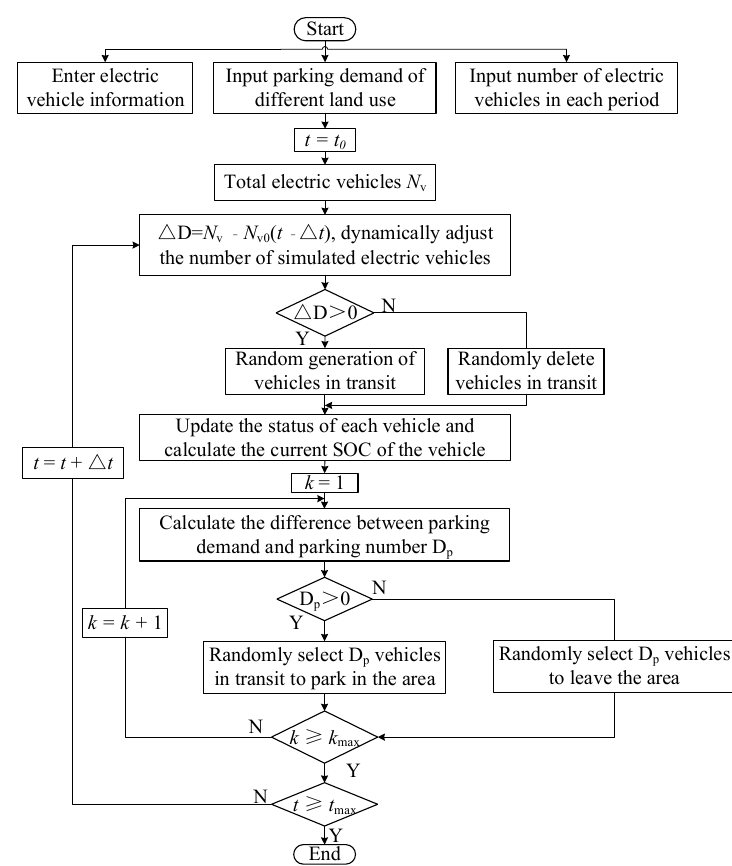
Figure 2. EV movement status update process based on